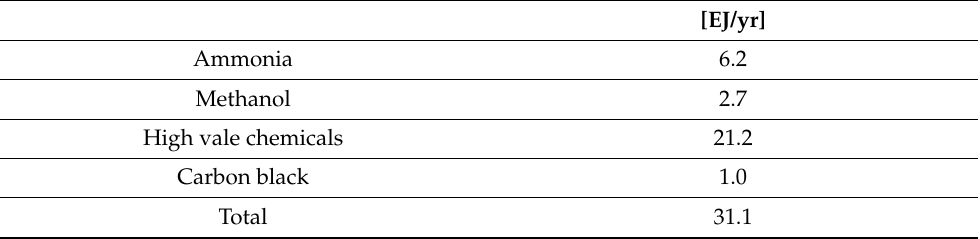
Table 2. Estimated global energy and non-energy use per type of product, 2017. [EJ/yr] Ammonia 6.2 Methanol 2.7 High vale chemicals 21.2 Carbon black 1.0 Total